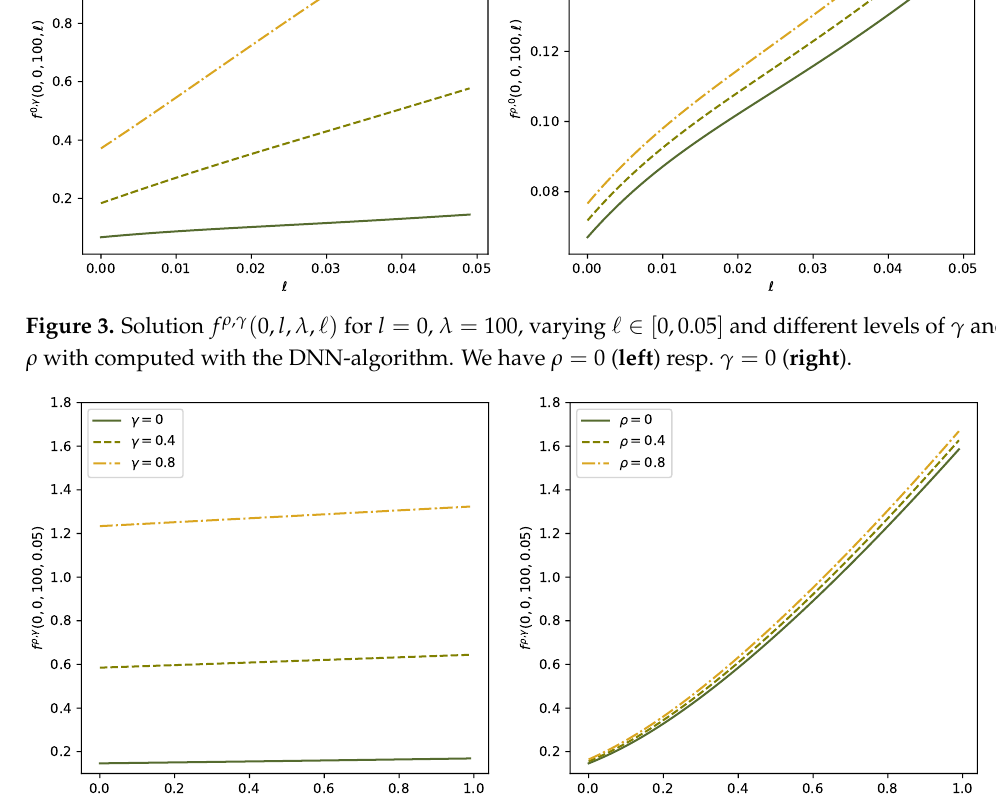
Figure 4. Solution ρ , γ ( 0, l , λ , (cid:96) ) for l = 0, λ = 100, (cid:96) = 0.05 varying ρ ∈ [ 0,1 ] and different levels of γ ( left ) and varying γ ∈ [ 0,1 ] for different levels of ρ ( right ) computed with the DNN-algorithm. This part of the case study highlights the computational advantages of the DNN approach compared with nested Monte Carlo methods. Figure 5 shows f ρ , γ ( 0, l , λ , (cid:96) ) for varying claim-arrival intensity λ together with reference solution points computed with classical Monte Carlo simulations. In this nested Monte Carlo problem, we use 3000 simulations to approximate the inner function u and 2000 path simulations for the outer expectation. The integral term is approximated following the trapezoidal rule on the time grid 0 = t 0 < t 1 < · · · < t N = T . Computation of only one point takes more than 5 min (despite using only 3000 resp. 2000 simulations). On the other hand training the network approximations of u ( t n , · , · ) for all n = 0, . . . , N − 1 takes around 20 min and training of the network approximation for f ( 0, · , · , · ) takes ess than 4 min, i.e., it takes only around 24 min to train the network for the whole space domain B and for all values of ρ , γ ∈ [ 0, 1 ] . This should be contrasted with a computation time of more than 60 min to compute the CVA for only 12 space points (numerical details on the training procedure are given in Remark 2). Due to the computational infeasibility of nested Monte Carlo solutions, we omit a similar error analysis as in